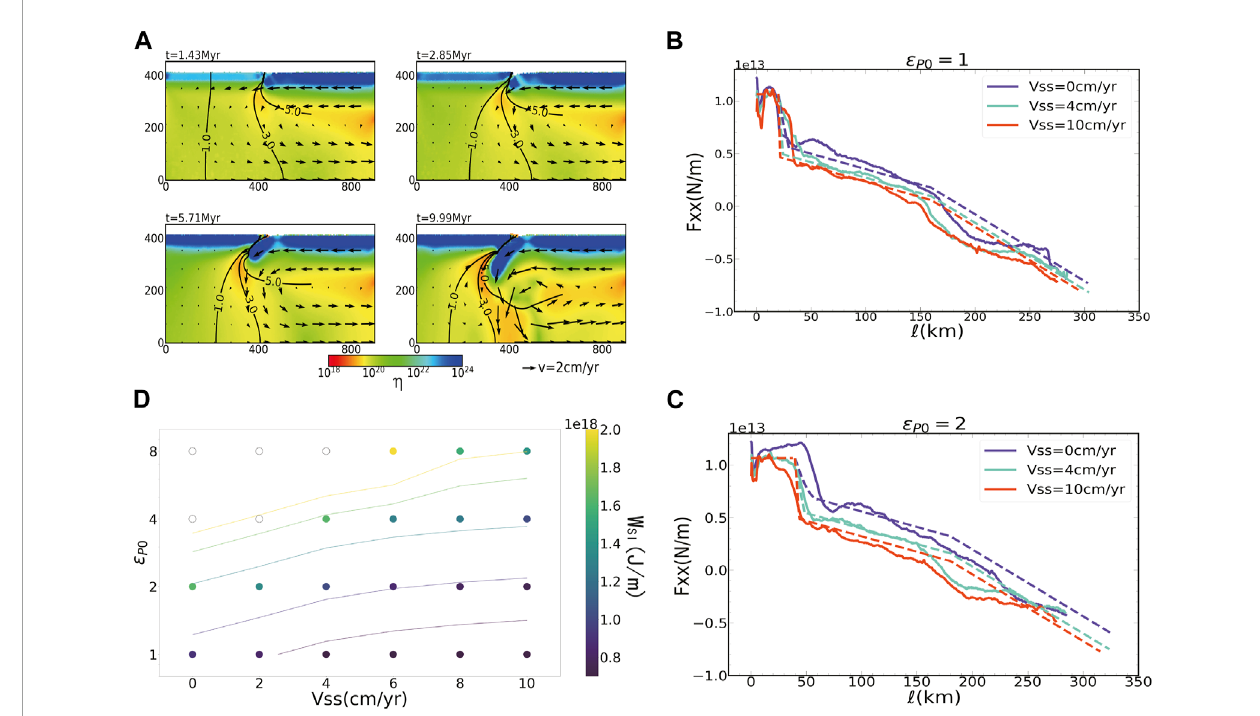
FIGURE 2 (A) An example of model with 1 cm/yr convergent velocity. Color shows the effective viscosity. Vectors show the in-plane component velocity and contours show strike slip velocity in cm/yr. (B) The integrated horizontal compressional force in the plate F xx as a function of plate motion ℓ for models with different strike slip velocity V SS under ɛ P 0 = 1. Solid line for numerical model results and dashed line for analytical results. (C) Same as (B) but with slower weakening rate ɛ P 0 = 2. (D) The work done to initiate a subduction W SI of every numerical model (color-coded solid circle) in the parametric grid search varying the strike slip velocity V SS and ɛ P 0 . Contours show the prediction of W SI from analytical